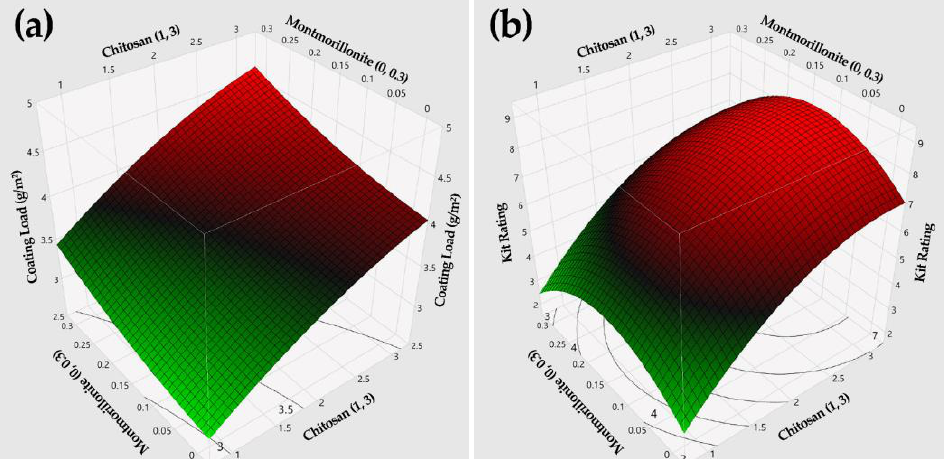
Figure 1. 3D surface profiles for ( a ) the coating load (g/m 2 ) and ( b ) the kit rating. Table 1. The CCD design of experiment and experimental responses. Variables Responses